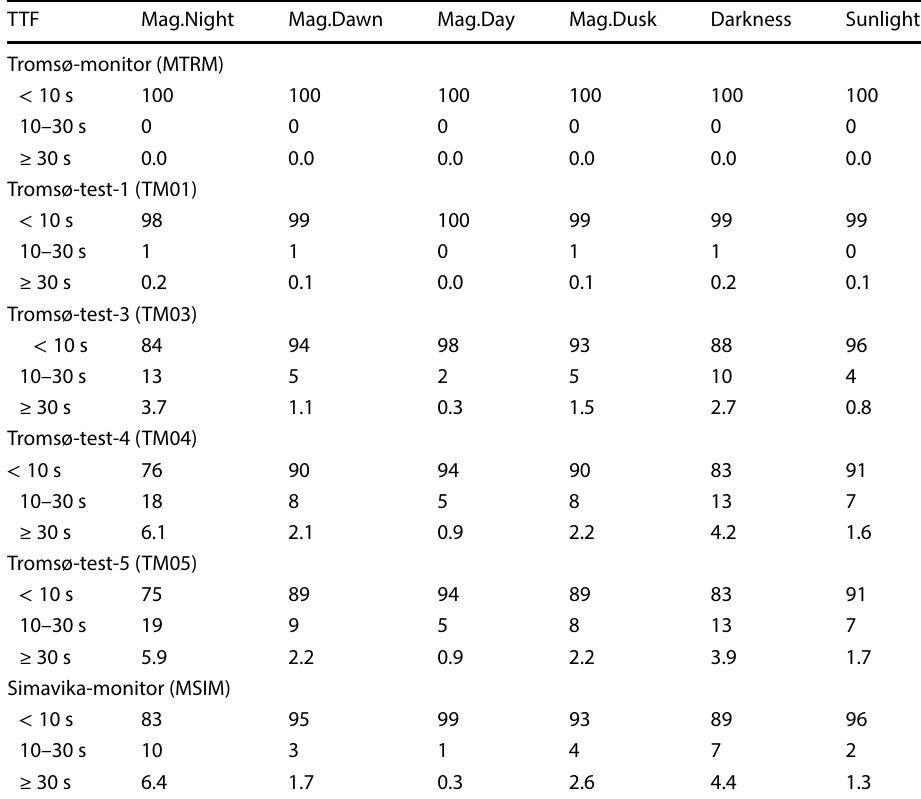
Table 4 Probability for time-